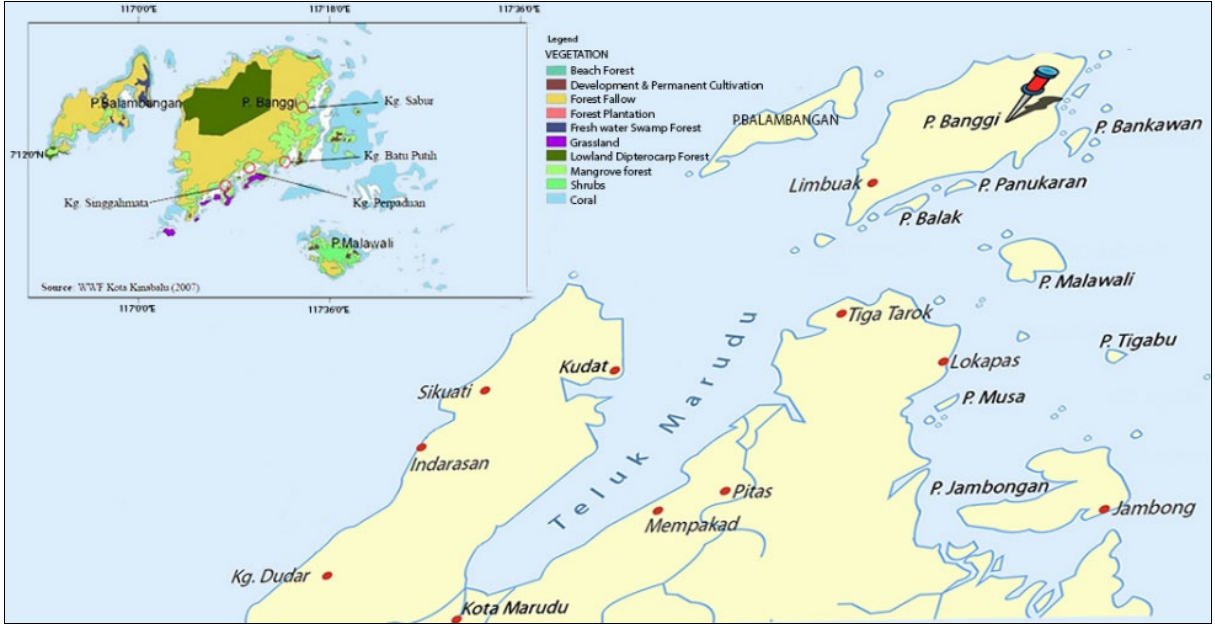
Figure 1. Location of Banggi Island at the tip of Borneo is in the South China Sea. The natural vegetation might be the source of the natural food ingredients for these honey bees on the island. There are a few important physicochemical properties such as pH, moisture content, HMF, and antioxidant properties, which are used to determine the quality of the honey [4]. The lower the pH, the lower the presence of microbial content because most of the microor- ganisms are unable to withstand acidic conditions. At the same time, the moisture content should be low as well because a highwater content promotes fermentation. HMF is used to determine the freshness of honey. Processing honey with a higher temperature or longer storage period can lead to a high HMF value [4]. Moreover, greater antioxidant properties are vital in biomedical activity. This study focuses on green honey from a different point of view. In this study, we determine the physicochemical properties of two types of green honey, namely, the commercially available bottled green honey (processed green honey) and freshly collected green honey from Banggi Island (raw green honey), where the brood- less honeycomb was pressed to obtain the green honey. Honey is mainly composed of sugar components, especially fructose and glucose, followed by sucrose and maltose [5]. Sugar in honey is responsible for the viscosity, and the hygroscopic and granulation characteristics of the honey. However, the sugar content of the honey depends on the botanical and geographical regions. Honey is prone to adulteration by the direct addition of a certain amount of sucrose syrup into the honey and also the addition of chemical colour to attract consumers